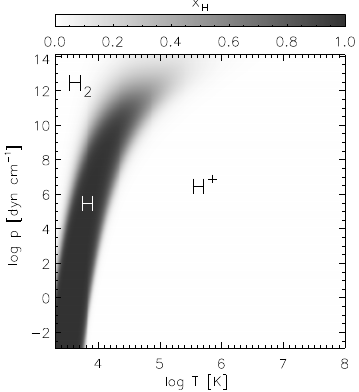
Figure 2. The ionisation fraction of hydrogen in the T – p grid com- puted with the VMW EOS. Those portions of the domain that are dominated by the neutral H, H 2 molecule and H + are